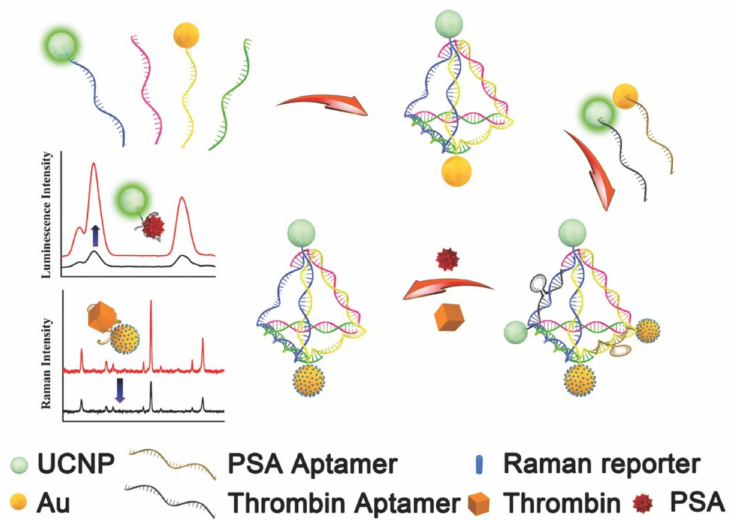
Figure 7. Working principle of the assembly process of the pyramid and the detection of distinct targets. Adapted with permission from Ref. [83]. Copyright (2017), John Willey and